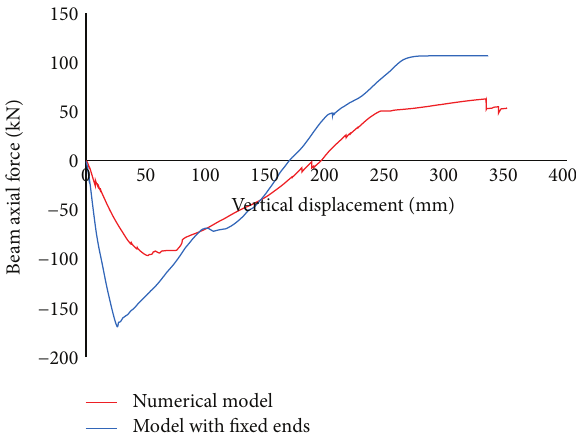
Figure 19: Comparison of beam axial force in numerical model with and without fixed